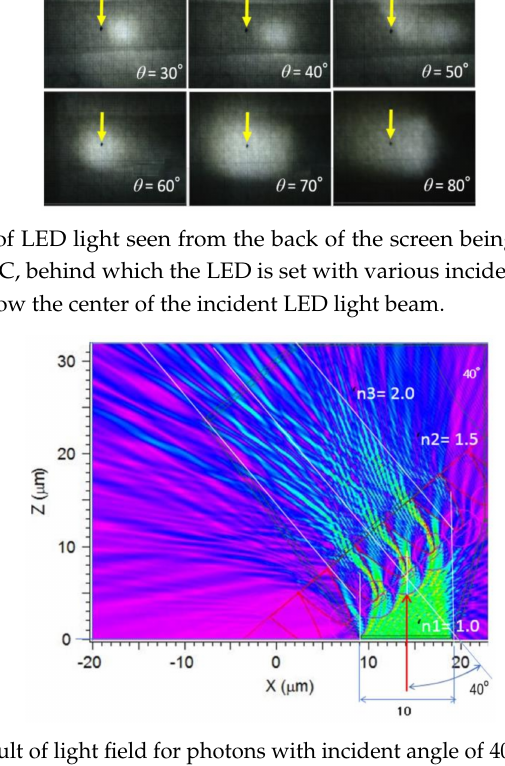
Figure 4. Simulation result of light field for photons with incident angle of 40 degrees. In the new PDC composed of paraboloid and